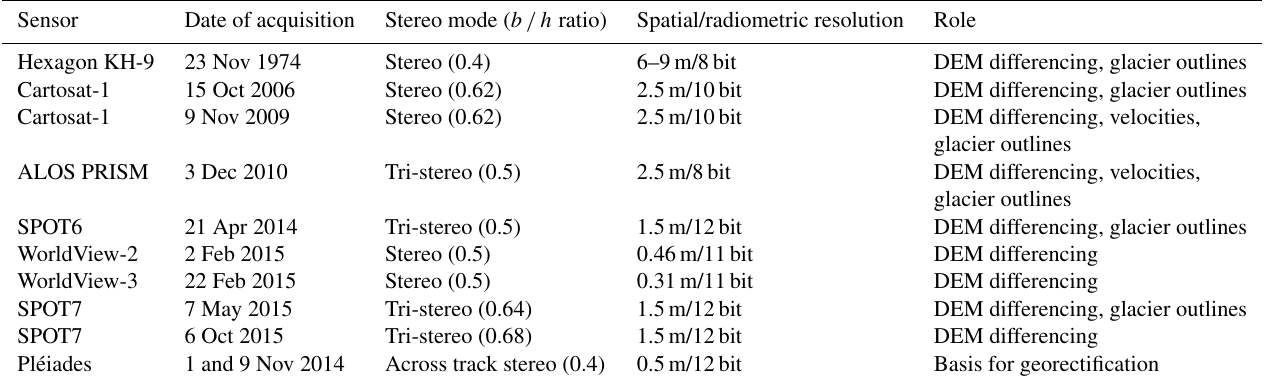
Table 2. Remote-sensing data